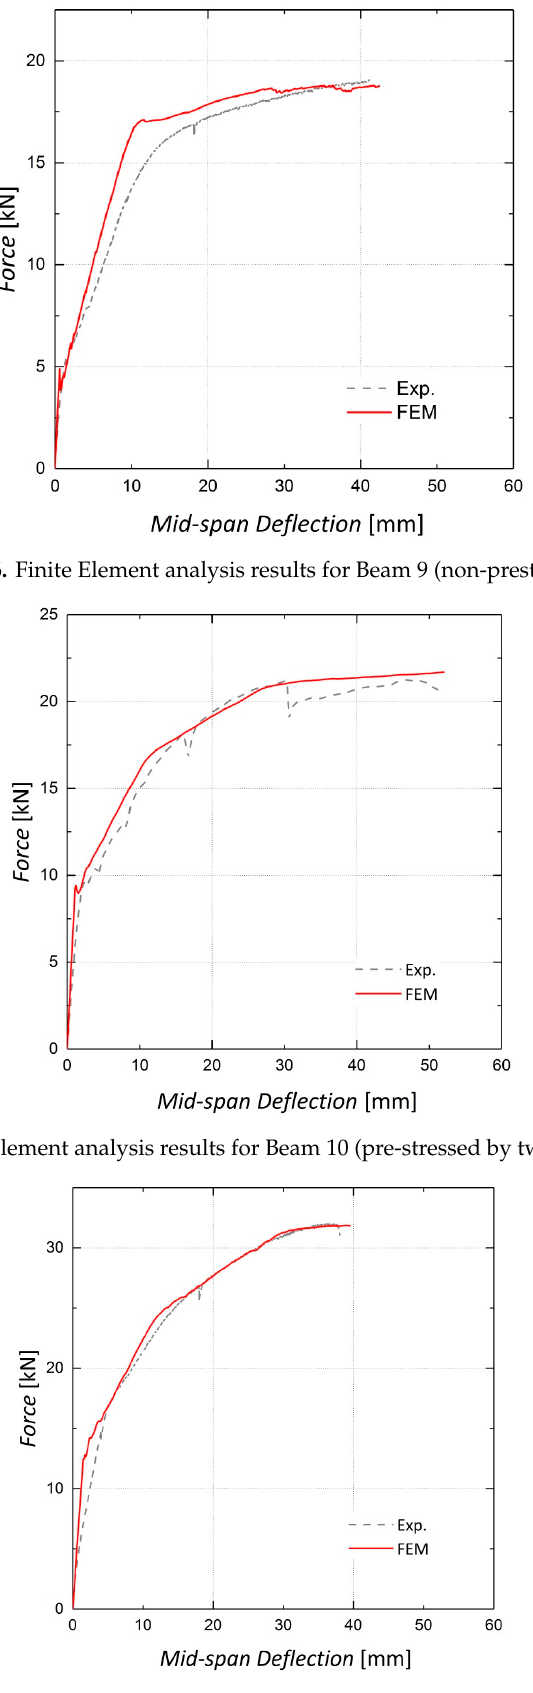
Figure 18. Finite Element analysis results for Beam 11 (pre-stressed by four Fe-SMA